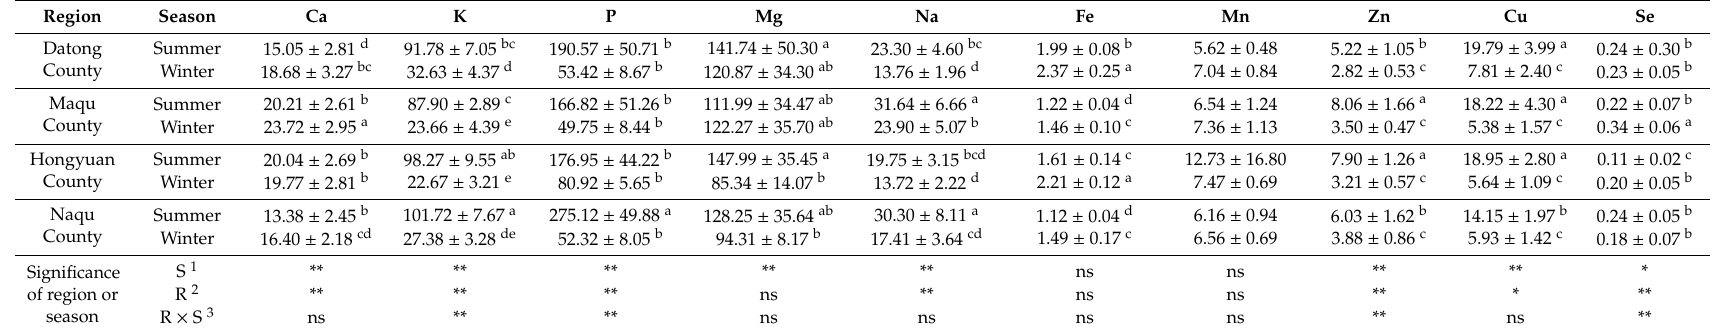
Table 4. Transfer factor (TF) in plants / soil (mean ± SE).